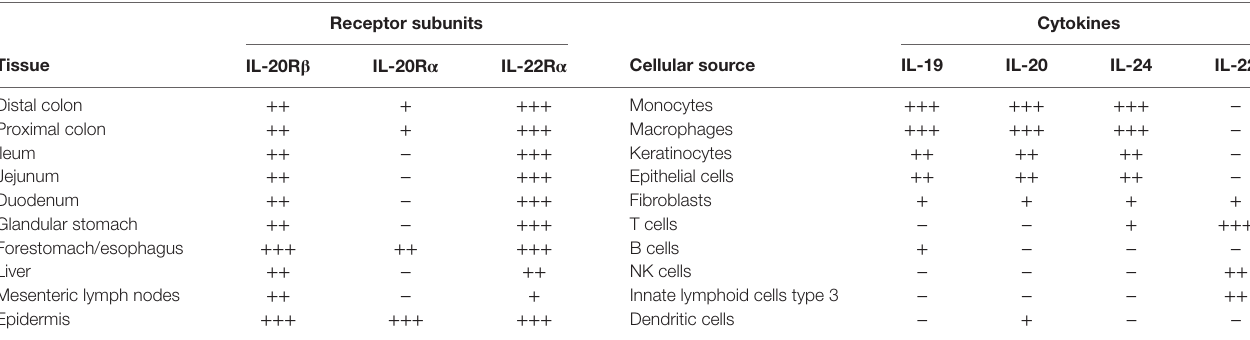
TABLe 1 | Expression of IL-20R β , IL-20R α , and IL-22R α in intestinal tissues, liver, epidermis, and mesenteric lymph nodes, and cellular source of IL-20 family cytokines.